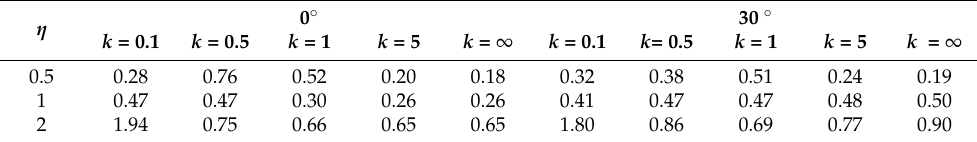
Figure 11. Coefficient of variation in horizontal direction. ( a ) 𝑘 = 0.1; ( b ) 𝑘 = 1 ; ( c ) 𝑘 = ∞ . Table 6. Mean value of variation coefficient of horizontal displacement amplitude (with permeability